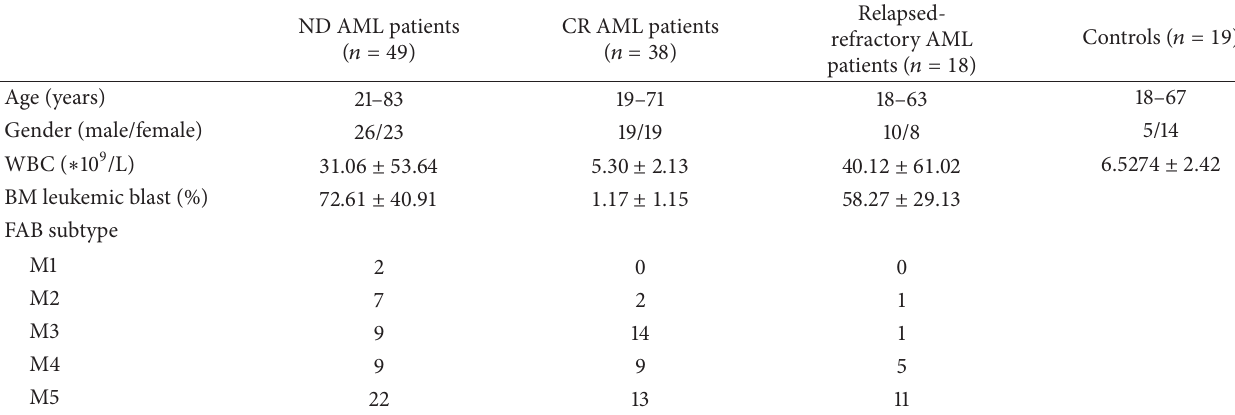
Table 1: The characteristics of